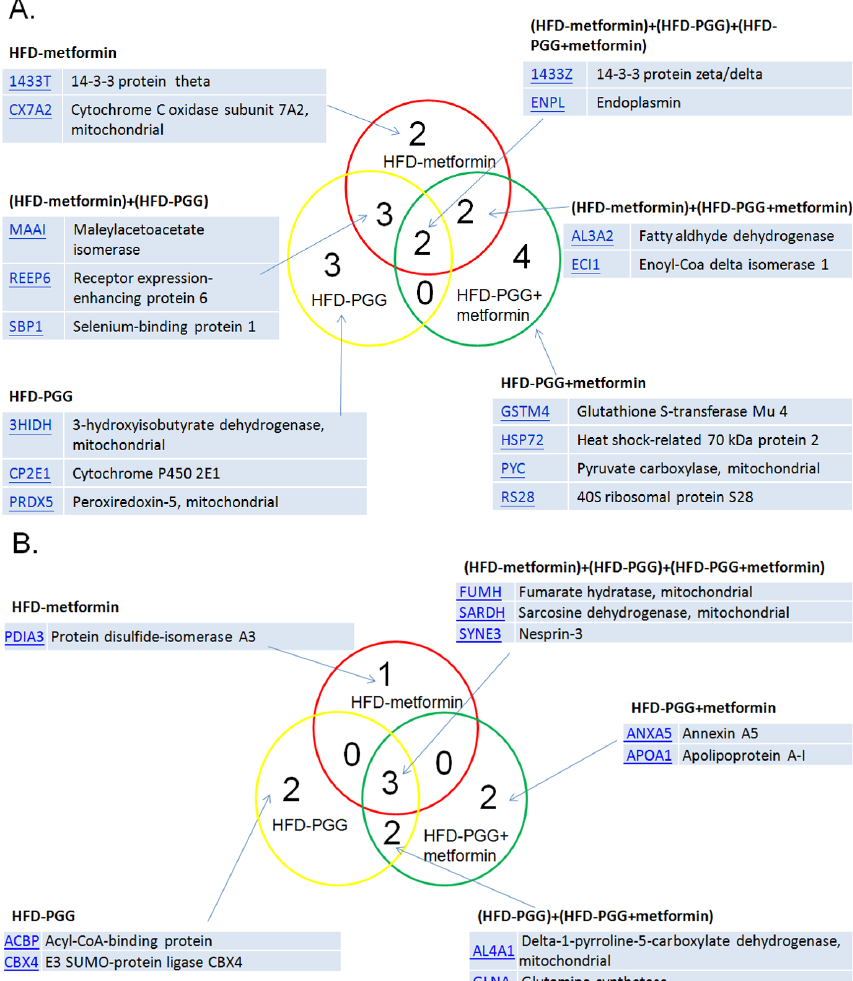
Figure 6. The summary of proteomic analysis results. ( A ) The MASCOT results indicate that 16 pro- teins were upregulated and ( B ) 10 proteins were downregulated among those three groups. (N = 3/group).